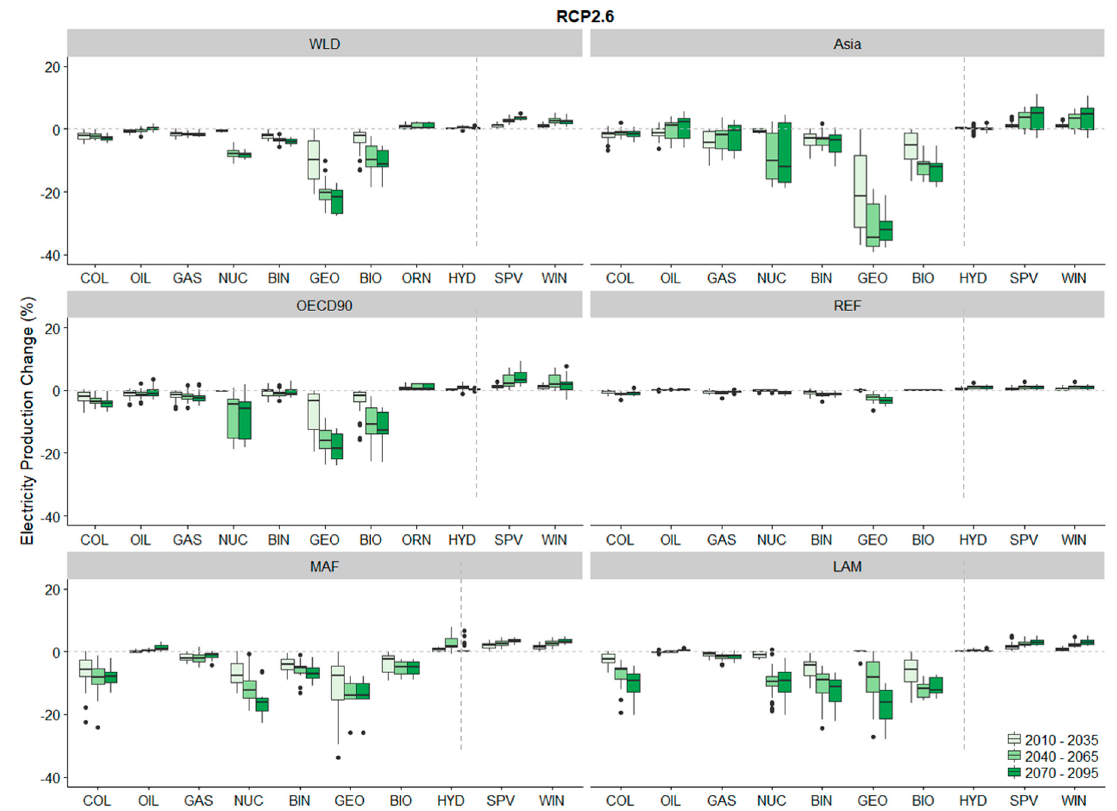
Figure 5. Differences in electricity production between the RCP2.6 and NoCC runs. The results of thermal and non-thermal sectors in three periods (2010–2035, 2040–2065, and 2070–2095) are shown. The range shows the variations in time and the differences among the five global GCMs.